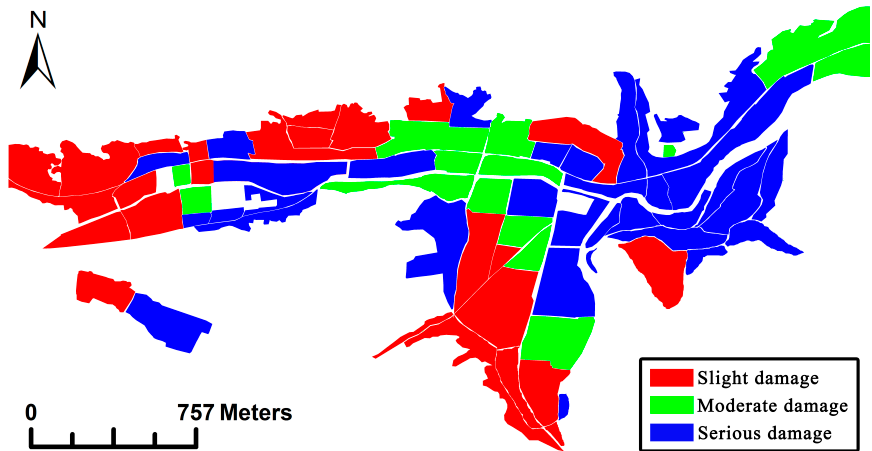
Figure 11. Building damage assessment (BDA) reference map at the scale of city blocks for the Yushu urban area. If the CB in a city block are less than one-third of the total buildings, the block will be considered as slight damage level (SLD). Serious damage level (SED) is defined as more than half of the buildings collapsed in a city block. If the building damage level (BDL) of a city block is between SLD and SED, the block will be regarded as moderate damage level (MOD).